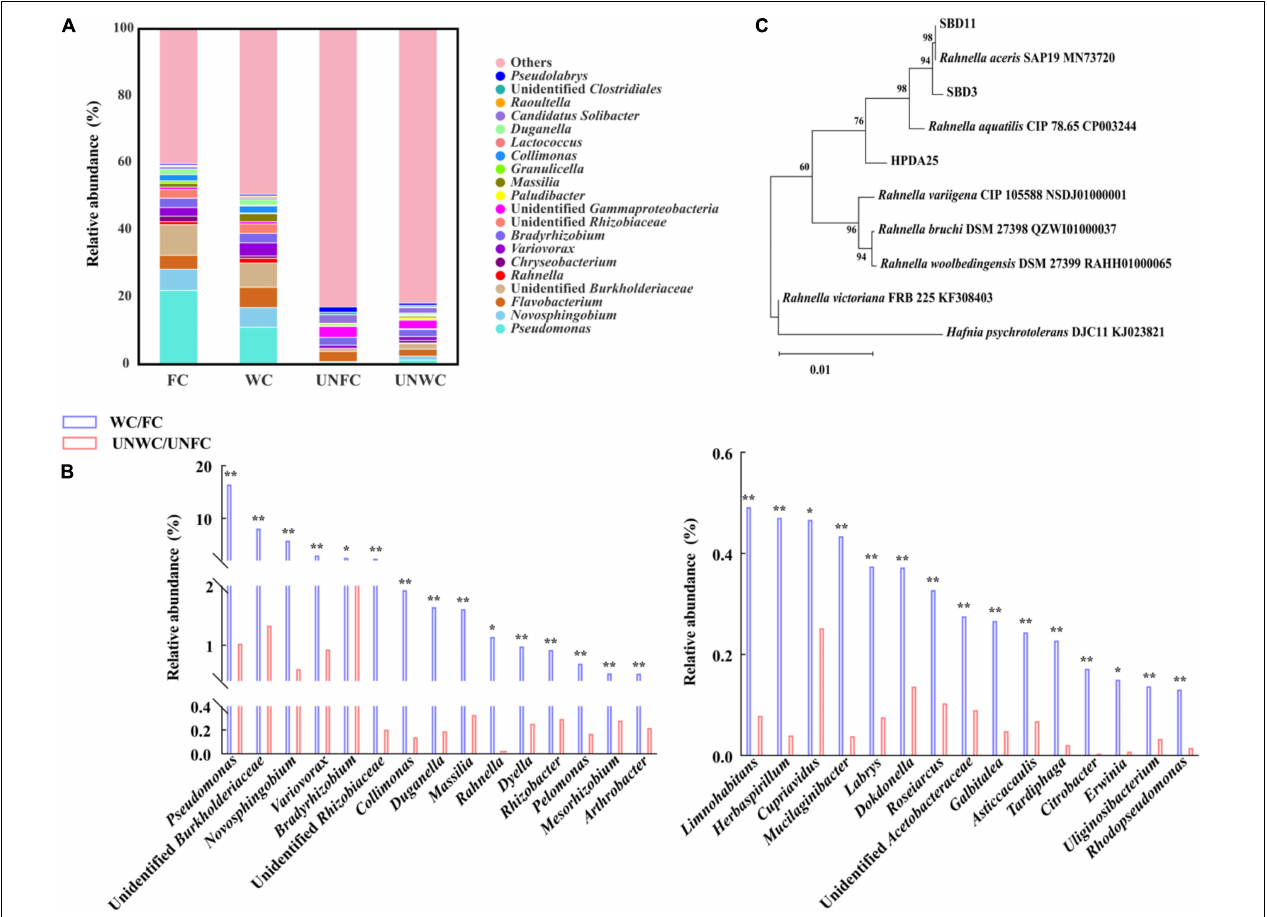
FIGURE 2 | Mycorrhizosphere bacterial diversity. (A) Mycorrhizosphere bacteria whose relative abundance was in top 30 at genus levels. (B) Top 30 genera with a significantly increased relative abundance in WC/FC soil samples compared with that in UNWC/UNFC soil samples. (C) Phylogenetic tree (neighbor-joining) of Rahnella isolates. WC, G. elata cultivated mycorrhizosphere soil from woodland cultivating G. elata ; FC, mycorrhizosphere soil from farmland cultivating G. elata ; UNWC, mycorrhizosphere soil from woodland uncultivating G. elata ; UNFC, G. elata cultivated mycorrhizosphere soil from farmland uncultivating G. elata . * P < 0.05; ** P <